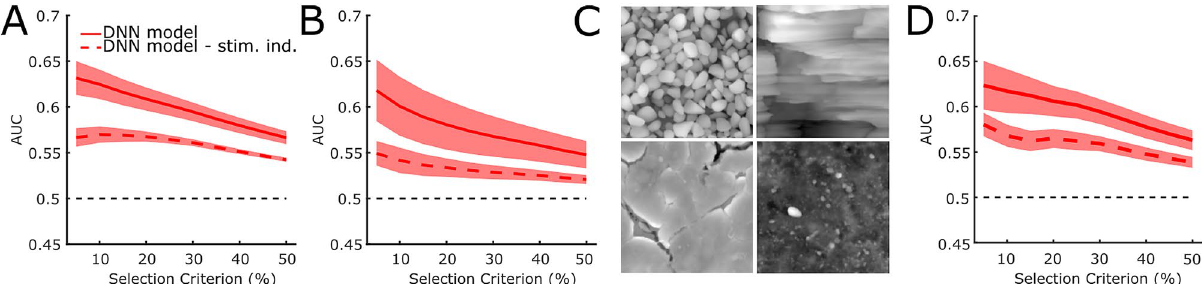
Figure 5. ( A ) Cross-validation ( B ) Generalization to free exploration. ( C ) Natural stimuli used in Experiment 3. ( D ) Generalization to natural textures. AUC (y-axis) computed with different selection criteria (x-axis). The lines represent the average across different models. Filled areas represent the standard error of the mean. Continuous lines represent the AUC based on the stimulus specific predictions; dashed line on the stimulus independent predictions.